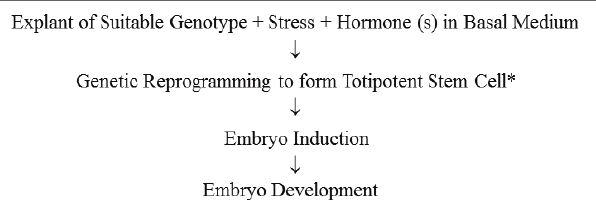
FIGURE 1 | Sequence of steps in somatic embryogenesis. *It has been shown by tracking of a single labeled cell that embryos can develop from single somatic cells (Schmidt et al., 1997). A multicellular origin proposed by Williams and Maheswarin (1986) to occur in some cases has not been unequivocally demonstrated. Haccius (1978) concluded that somatic embryos can derive from a single cell or proembryonal cell complexes which are derived from a single segmenting cell.